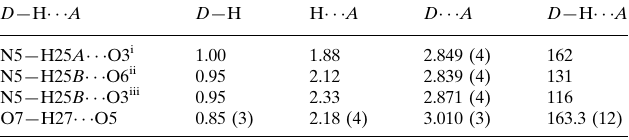
Hydrogen-bond geometry (A˚ , (cid:3)